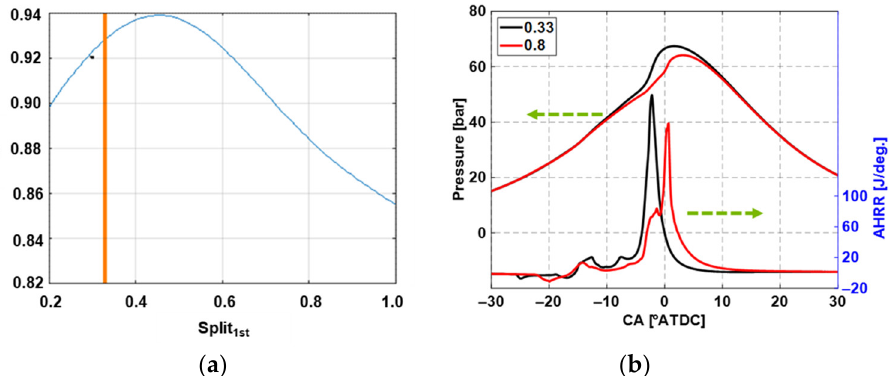
Figure 11. ( a ) The 2D response surface between combustion efficiency (ŋ c ) and fuel split ratio (split 1st ); ( b ) in-cylinder pressure and apparent heat release rate (AHRR) in different fuel split ratios.